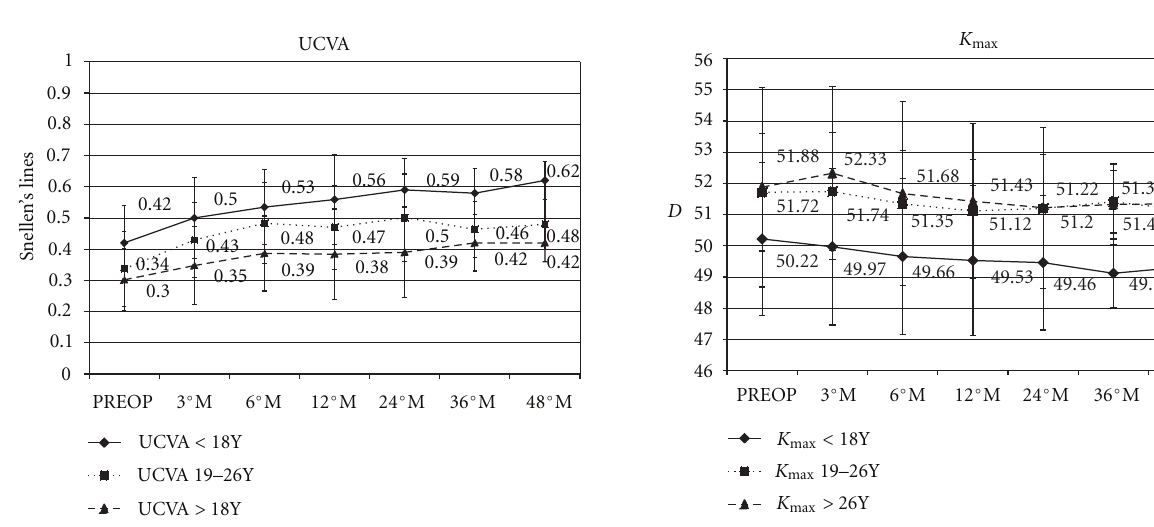
Figure 3: The graph showing computerized corneal topography results. The comparative topographic analysis showed a K max variation in paediatric group by a mean of − 0.7 D, − 0.8 D, − 1.1 D, and − 0.9D; in the intermediate group (patients between 19 and 26 years) varied by a mean of − 0.6 D, − 0.5 D, − 0.3 D, and − 0.6 D; in adult group (patients ≥ 27 years) varied by a mean of − 0.4 D, − 0.6 D, − 0.5 D, and − 0.5D, at 12, 24, 36, and 48 months of followup, respectively, for each group.